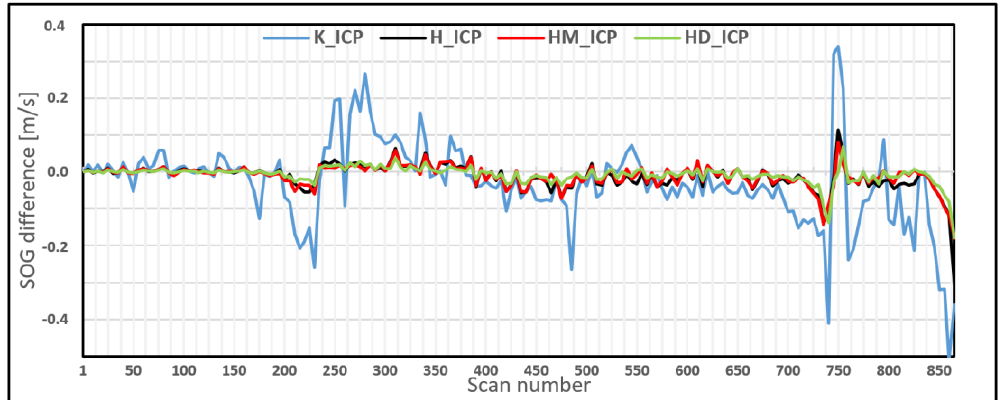
Figure 12. A graph of SOG ICP − SOG R differences.